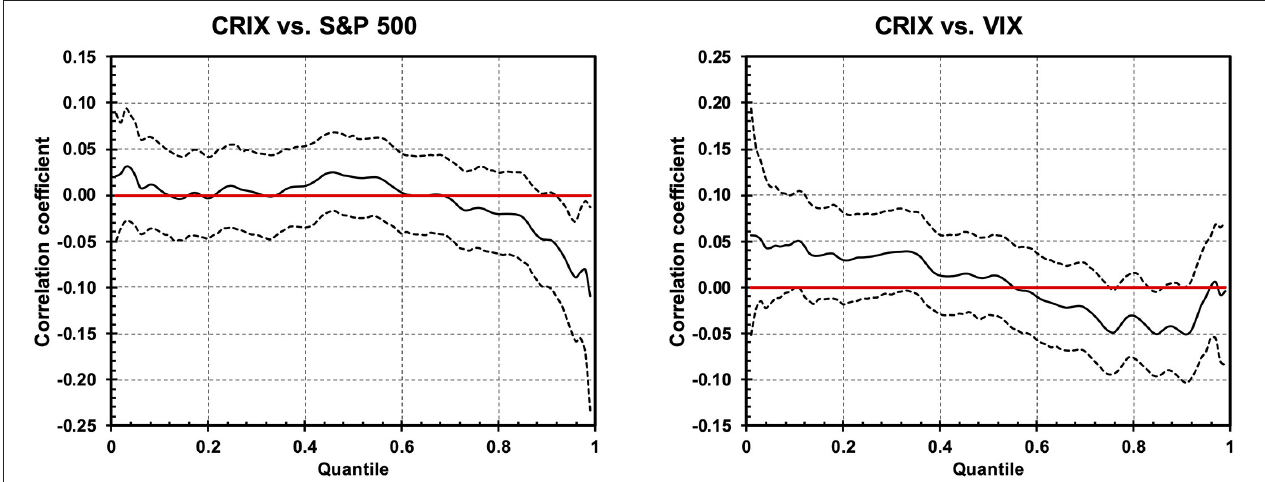
FIGURE 5 | Quantile correlations for CRIX with the S&P 500 (left) and the VIX (right). The notation from Figure 2